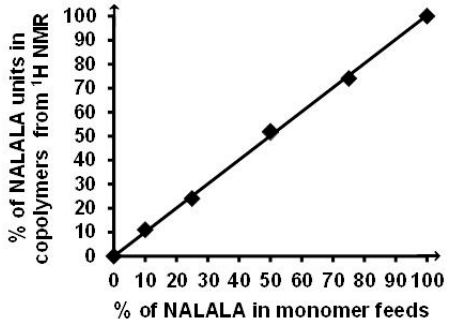
Figure 5. Linear correlation between copolymer and feed compositions. Differences between replicates are inside the size of data points.